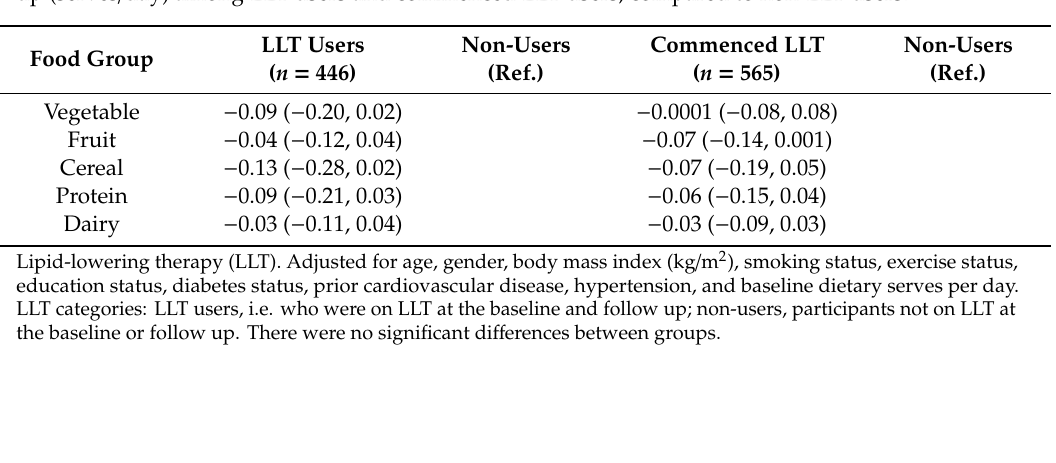
Table 4. Adjusted median (95% CI) intake at the 50th quantile for food group consumption at the follow up (serves / day) among LLT users and commenced LLT users, compared to non-LLT